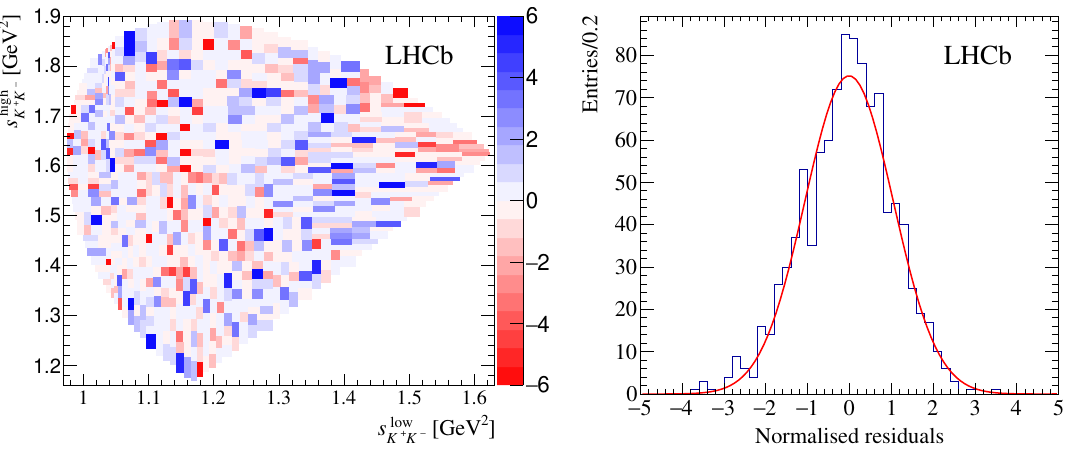
Figure 12 . (left) Two-dimensional distribution of the normalised residuals for the Triple-M (cid:12)t. (right) Distribution of normalised residuals of each